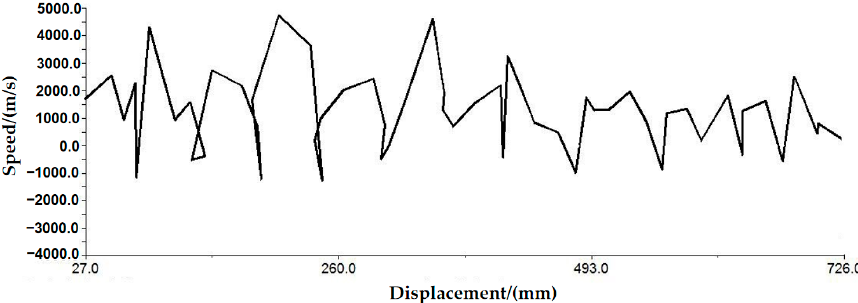
Figure 14. Velocity of link_1 in the y-direction vs. displacement in the x-direction.